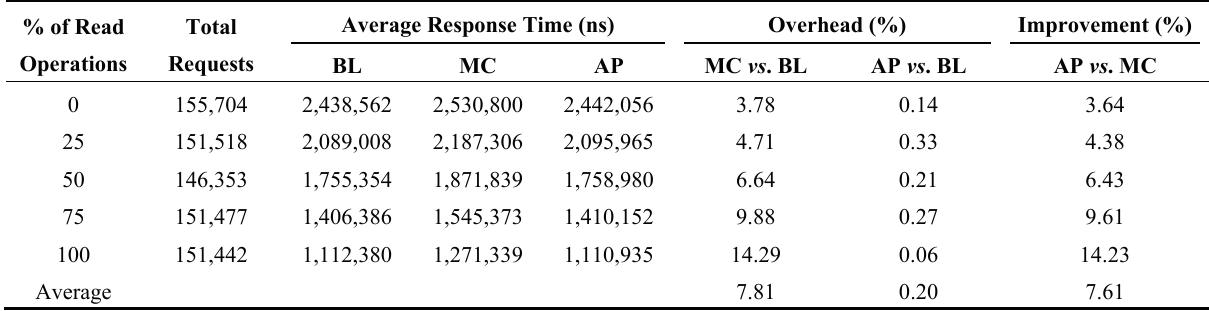
Table 7. The I/O performance for Baseline, Meta-Cure, and Asymmetric Programming with different percentages of read operations (BL: Base Line; MC: Meta-Cure; AP: Asymmetric Programming).